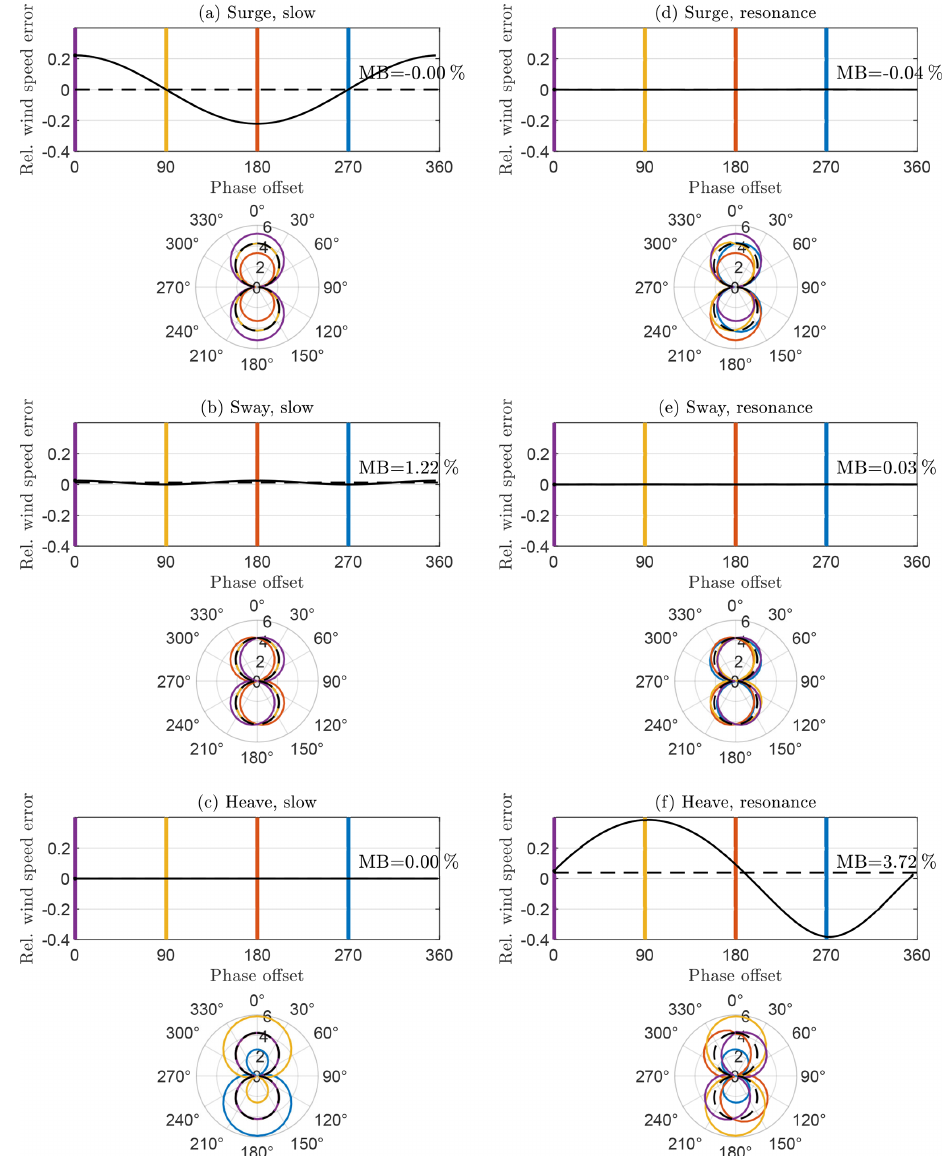
Figure 9. Relative motion-induced measurement error caused by motion in 3 translational degrees of freedom (top to bottom) with very low oscillation frequency (a, b, c) and oscillation in resonance with the lidar prism ( f p = f s = 1Hz) (d, e, f) . Figures of eight are given for four phase offset angles marked by colors. U = 8 . 5ms − 1 and ˆ v = 1 . 88ms − 1 ( κ = 0 . 22). Dashed black figures of eight correspond to fixed lidar measurements for comparison. Mean bias (MB) marked by dashed horizontal